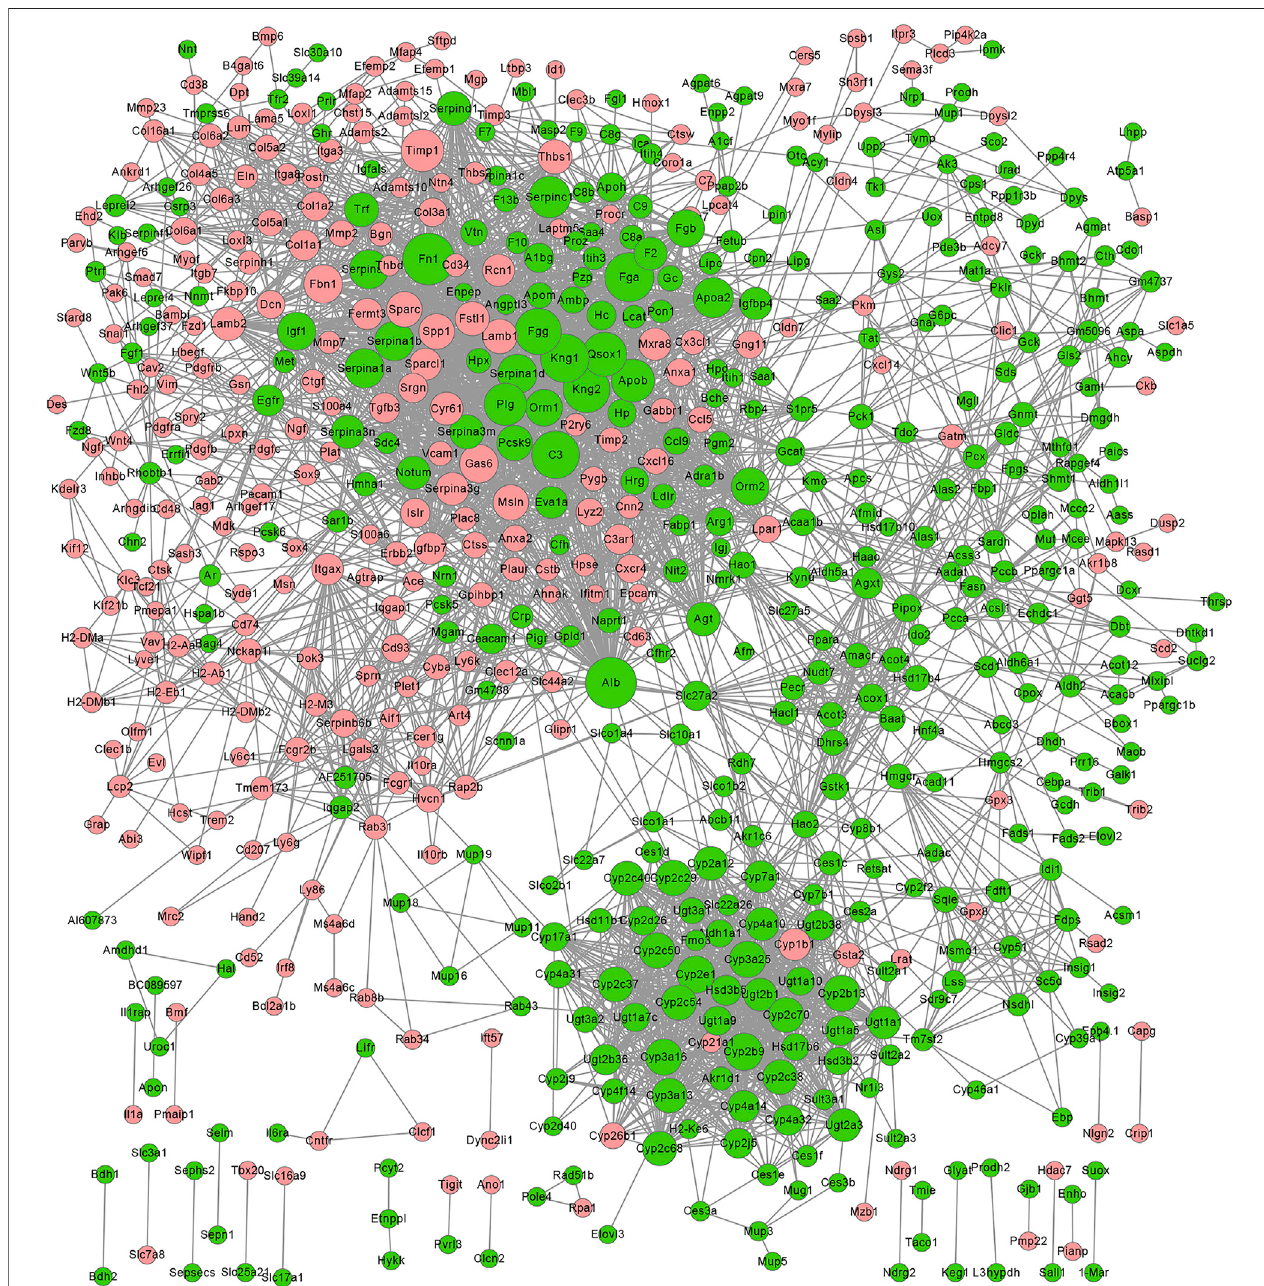
FIGURE5 | Four keymodules network (A – D) ofPPInetwork forDEGs reversedby GDFMD withWD.Pink nodes denote up-regulated genes; PPI, protein-protein interaction; DEGs, differentially expressed genes.